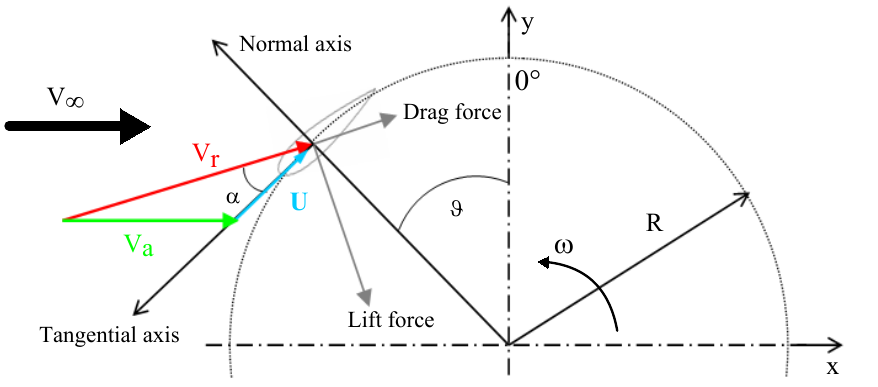
Figure 4. Azimuthal coordinate of the blade midsection’s center of pressure and blade velocity vectors.